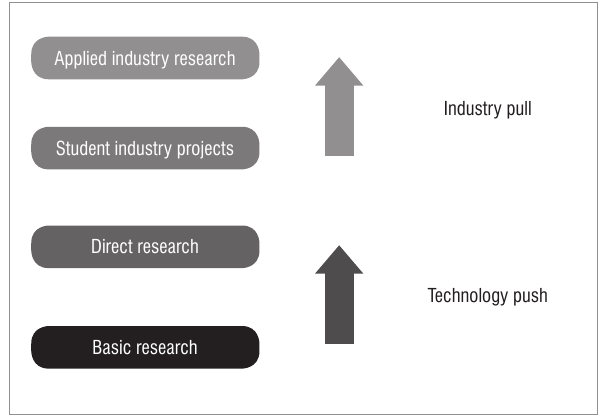
Figure 3: The knowledge-production